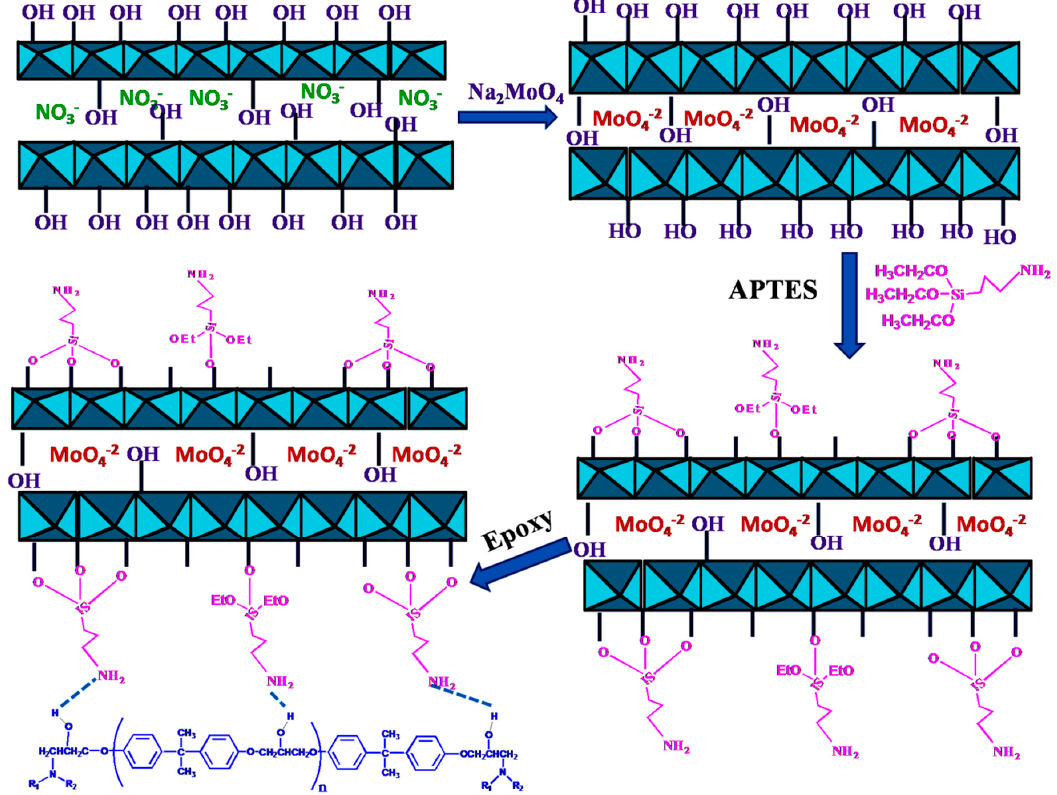
Figure 1. Schematic for the intercalation and modification of layered double hydroxide (LDH) and the possible interaction with the epoxy matrix.